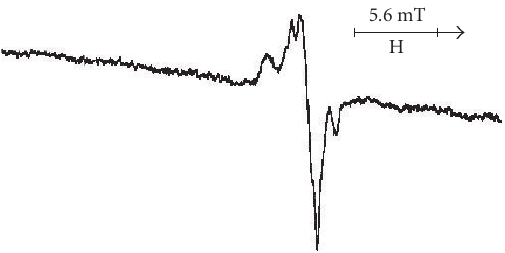
Figure 4: The ESR spectrum with three superfine components ( Δ H = 3 . 11mT, g -factor 2 . 003) of irradiated collagen (223K, pH 3 . 7).